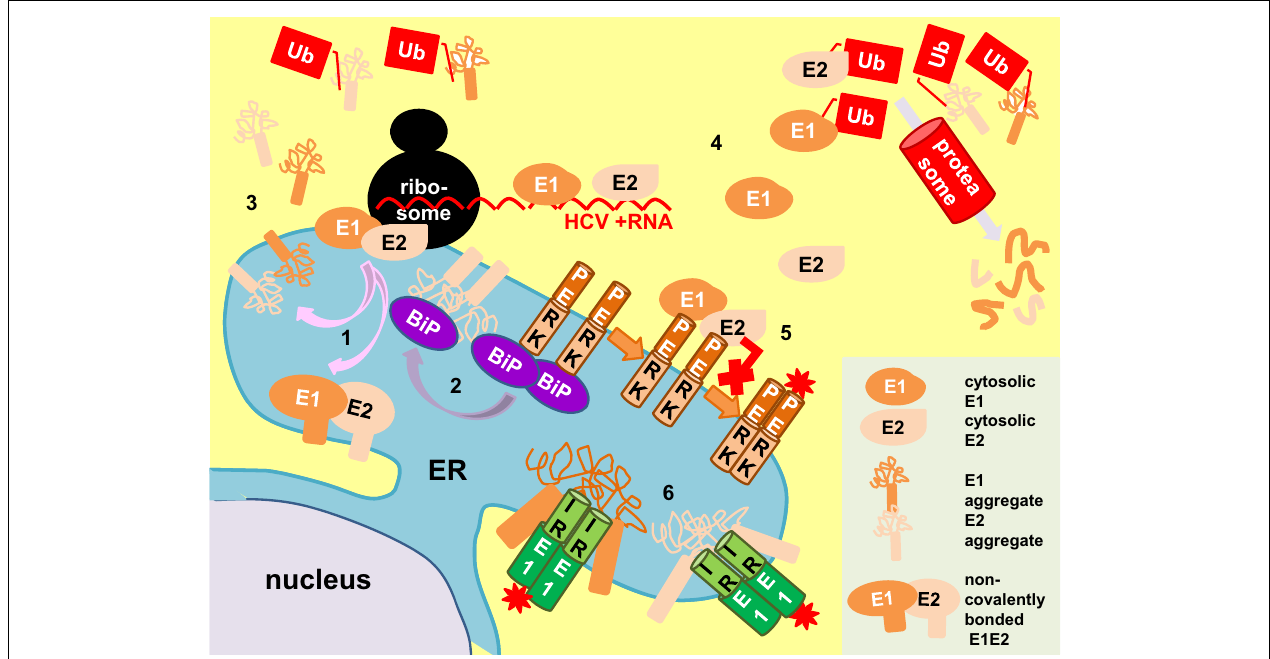
FIGURE 5 | Proposed mechanisms of E1/E2 activation of UPR. E1 and E2 are targeted and mature in the endoplasmic reticulum (ER) to form non-covalently-bonded heterodimers and disulphide-bonded aggregates (pink arrows, 1). The E2 aggregates distract BiP from PERK (purple arrow), allowing PERK oligomerization and activation (brown arrows, 2). Retrotranslocated (3) and cytosolic E1/E2 from surplus protein synthesis